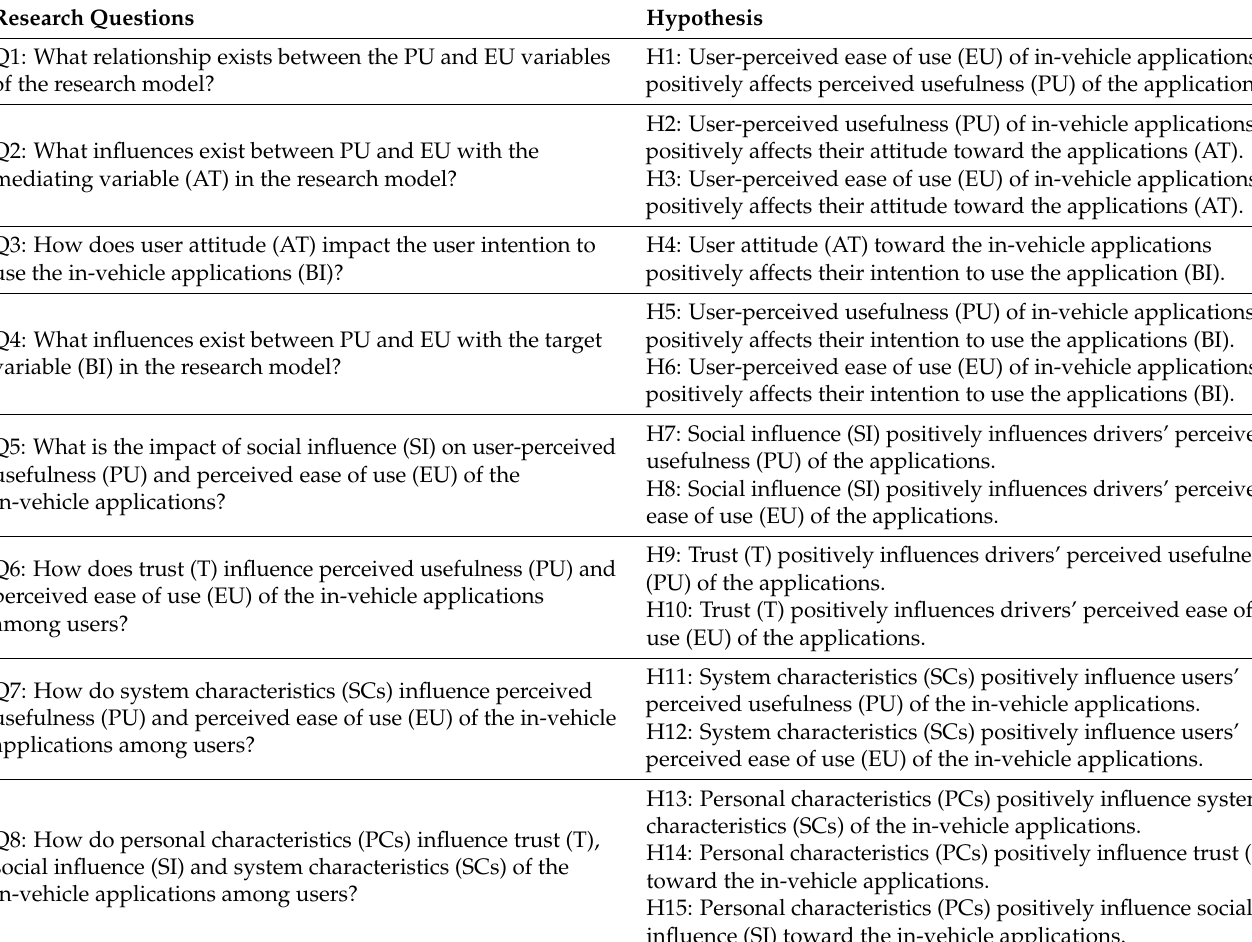
Table 5. Research questions and